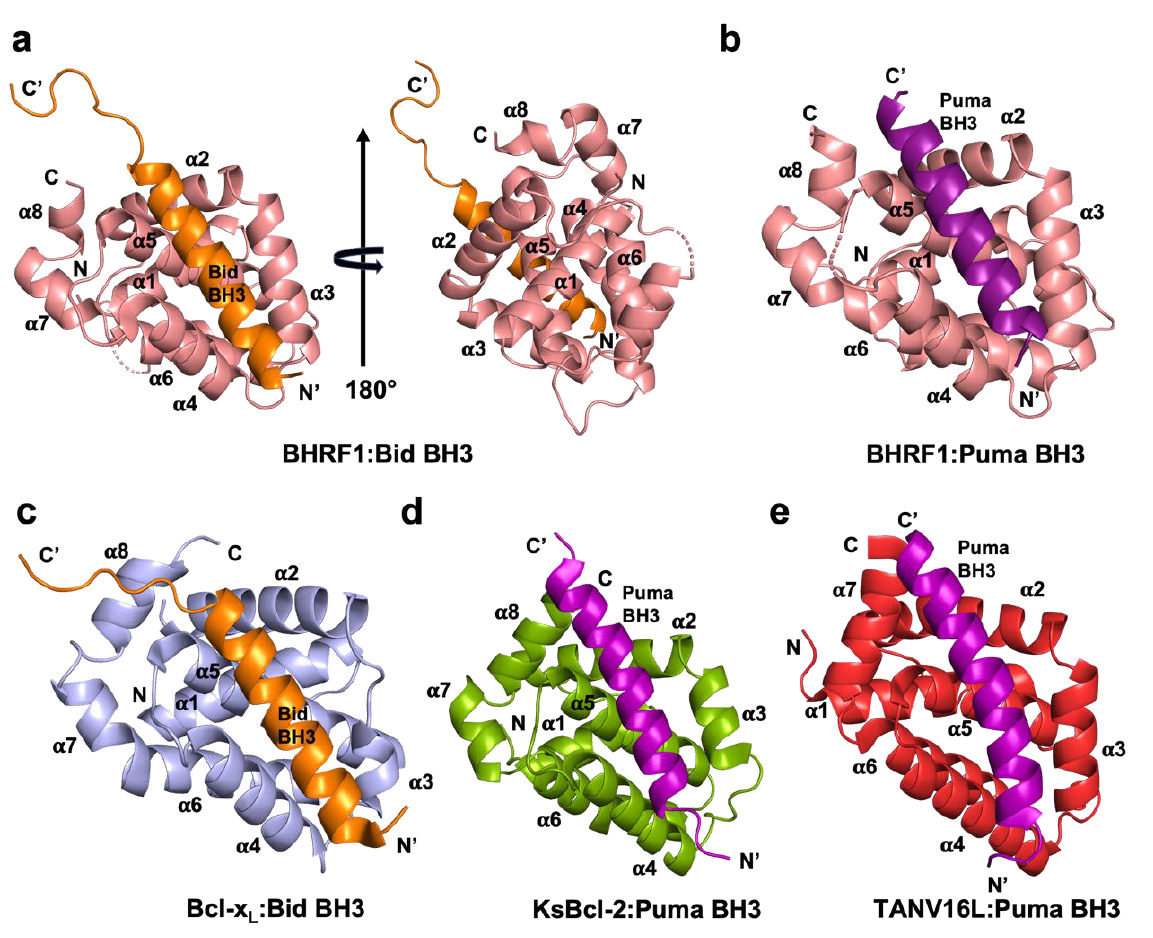
Figure 1. EBV BHRF1 binds BH3 motif peptides of proapoptotic Bcl-2 proteins using the canonical ligand-binding groove. ( a ) Ribbon representation of the crystal structure of BHRF1–Bid BH3 (PDB ID 7P33) complex and its 180 ◦ rotation. BHRF1 is shown in salmon, while BidBH3 is shown in orange, with BHRF1 helices labeled α 1– α 8. The view is into the hydrophobic binding groove formed by helices α 2– α 5. ( b ) Ribbon representation of the crystal structure of BHRF1–Puma BH3 (PDB ID 7P9W) complex. BHRF1 is shown as the salmon cartoon, while PumaBH3 is shown in purple. The view is as in ( a ). ( c ) Cartoon of Bcl-x L –BidBH3 complex. Human Bcl-x L is shown in light blue, while Bid is shown in orange. ( d ) Cartoon of KSHV KsBcl-2–Puma BH3 complex. KsBcl-2 is shown as an olive-colored cartoon, while Puma is shown in purple. I Cartoon of tanapoxvirus TANV16L–Puma BH3 complex. TANV16L is shown as a red-colored cartoon, while Puma is shown in purple. The views in ( c – e ) are as in ( a ).